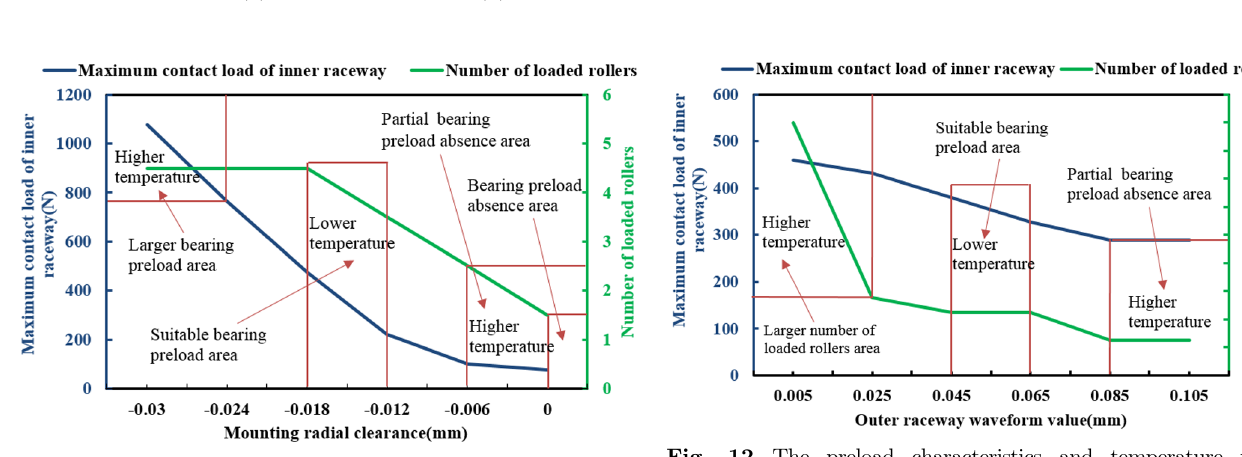
Fig. 10. The maximum contact load variation of inner raceway and the number of loaded rollers variation under the different inner ring rotational speeds: (a) single-pressed state; (b) double-pressed state.